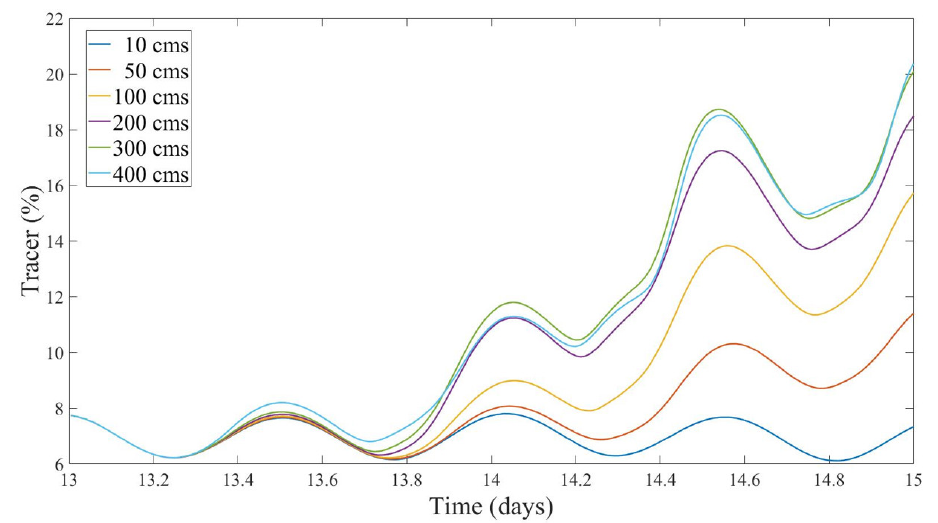
Figure 16. Model results of different river discharges (10–400 m 3 /s) show that the percentages of ammonium from the NHW river entering the harbor have a slope-positive trend, with oscillations in response to the flood–ebb tidal cycles—the harbor ammonium percentage increases with time and the increasing flux of the NHW river except for the 10 m 3 /s flux.